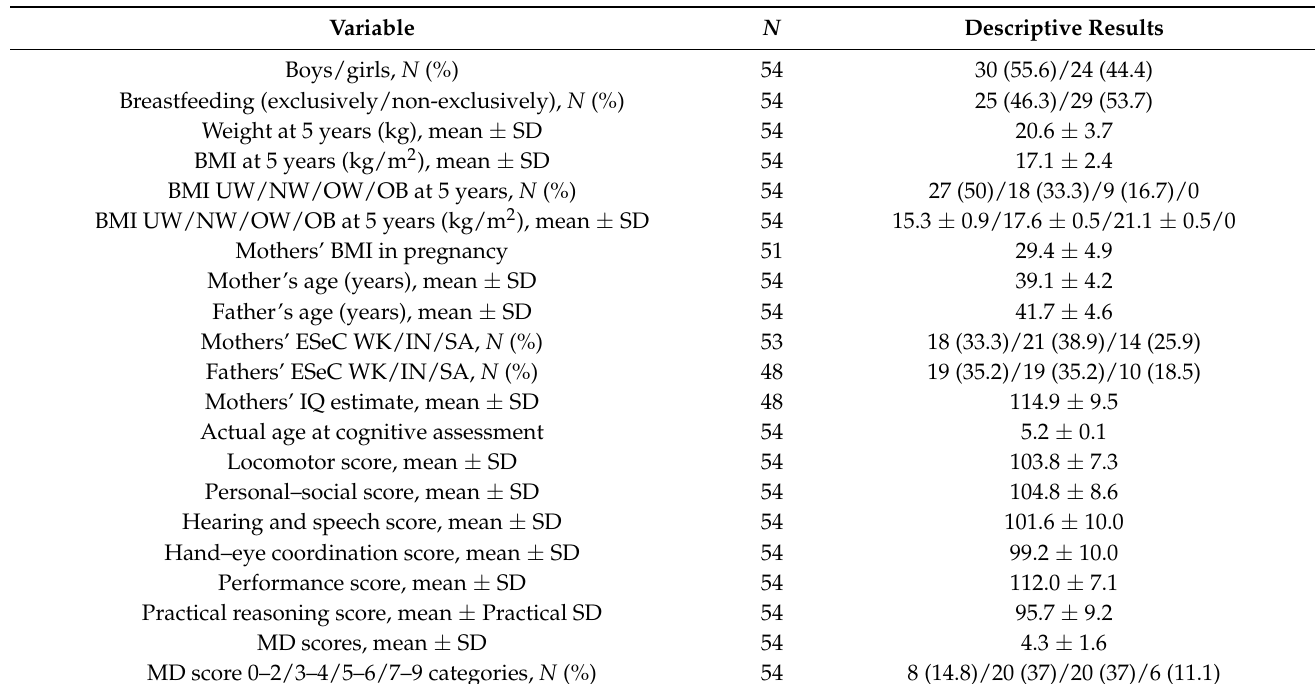
Table 1. Characteristics of the study population.